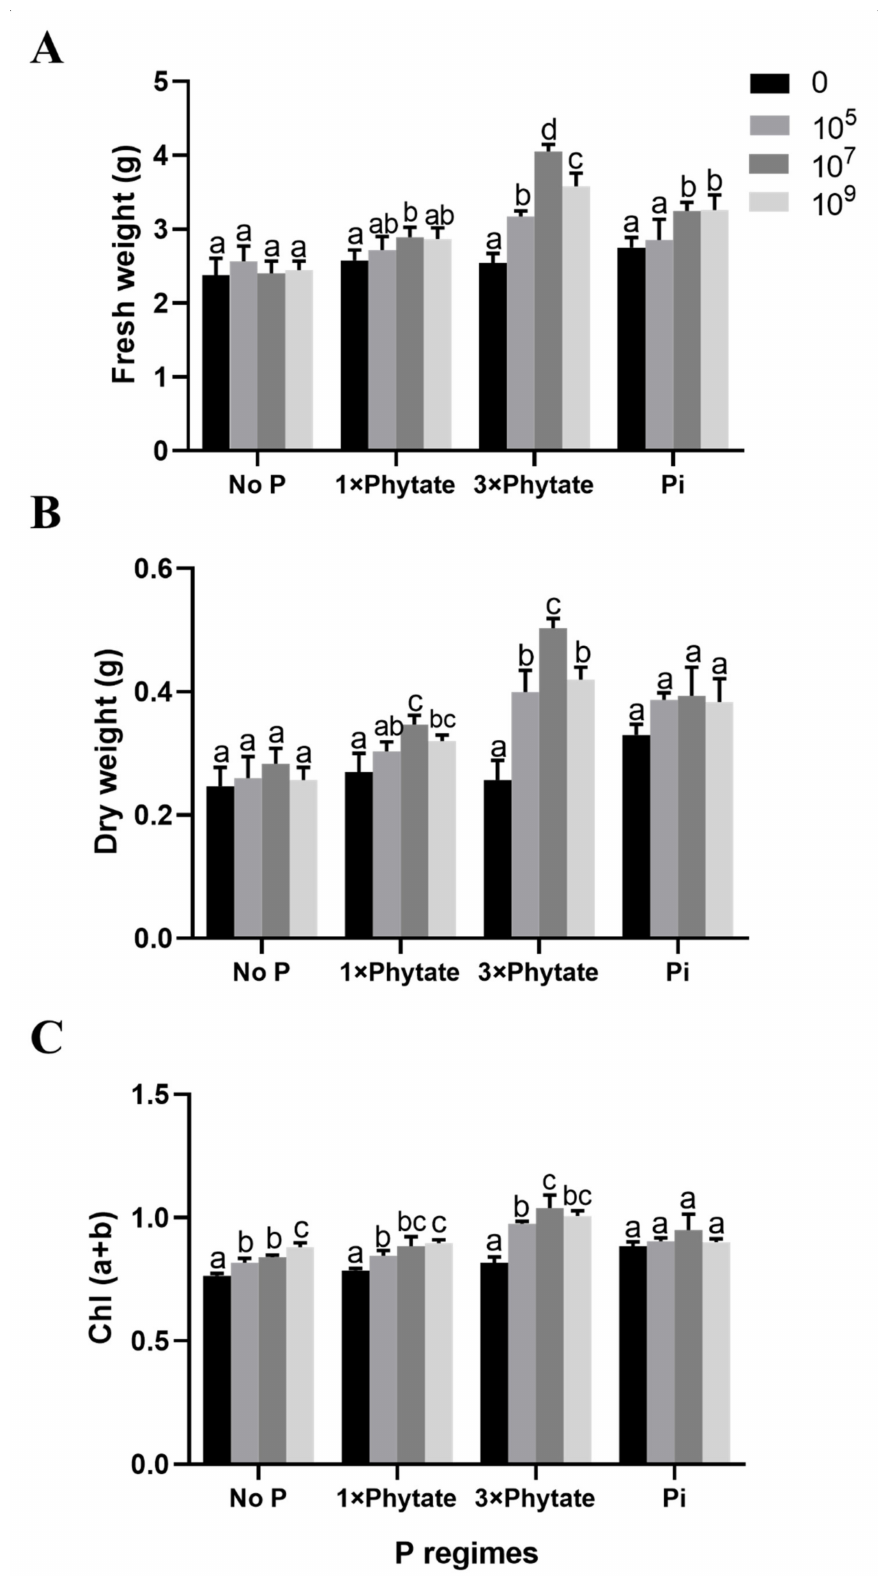
Figure 6. Effects of inoculation with three different concentrations of R. aquatilis JZ-GX1 under four different P regimes on ( A ) Fresh weight accumulation, ( B ) Dry weight accumulation and ( C ) Chlorophyll content. Different letters indicate statistically significant differences ( p < 0.05) among treatments according to the least significant difference